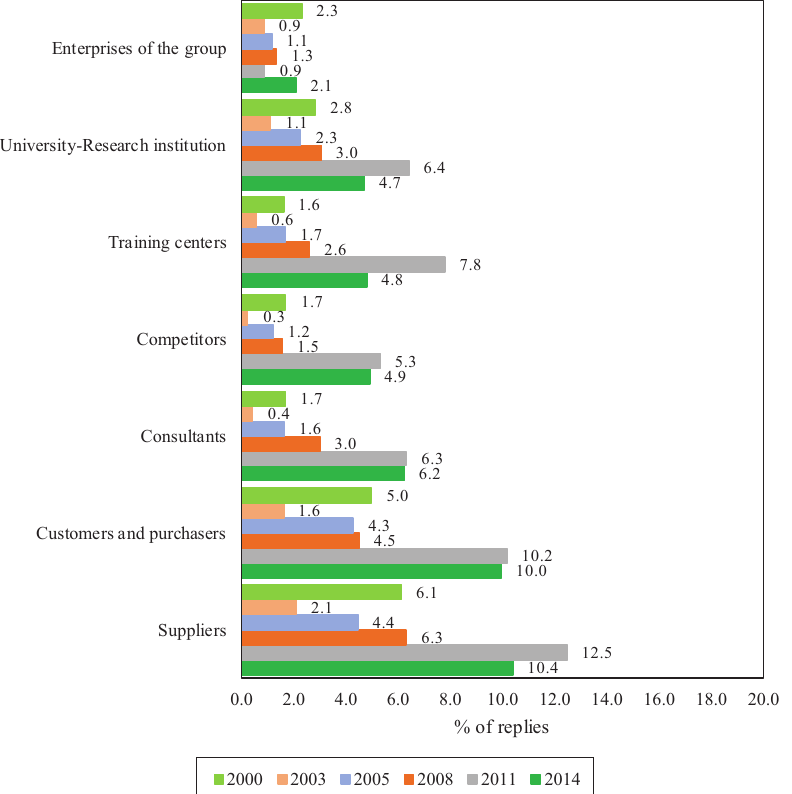
Figure 4. Most frequent partners for interaction, according to the